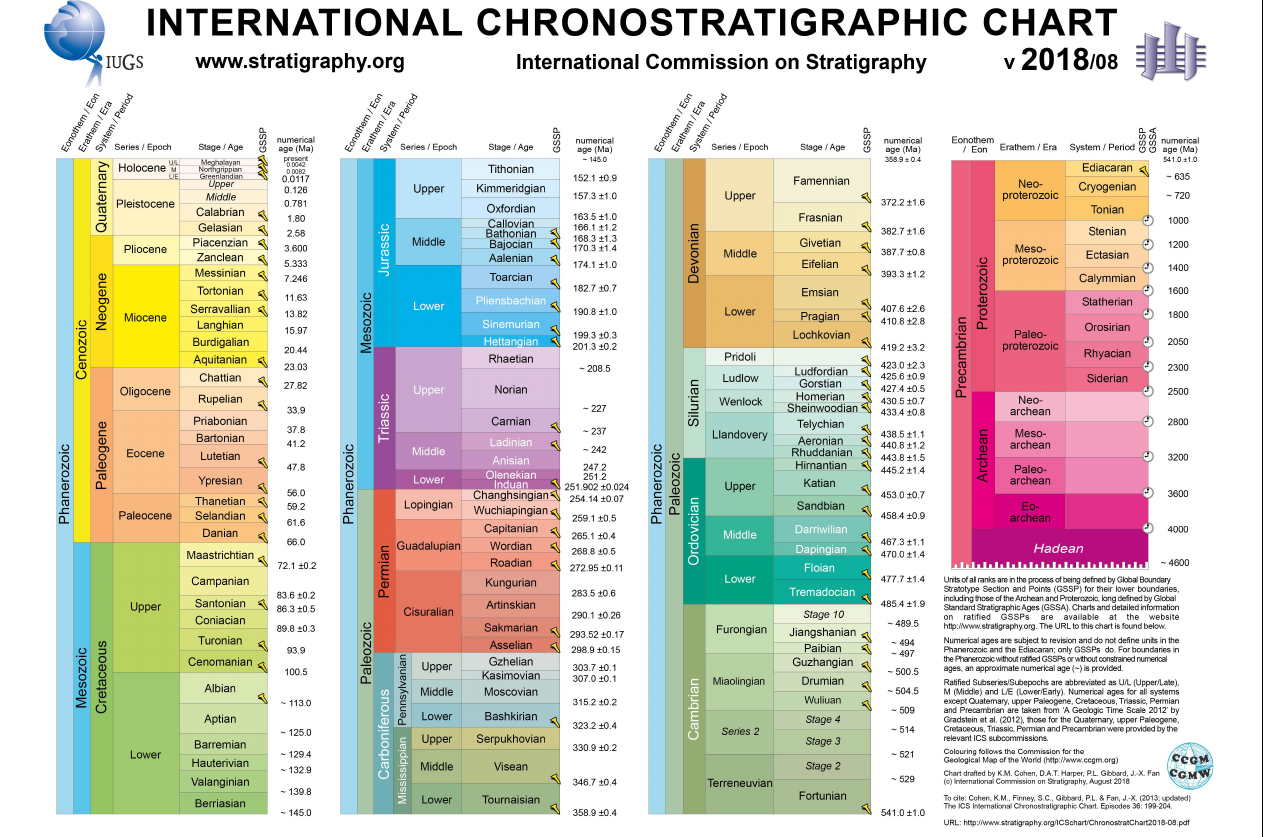
FIGURE 1 | The International Chronostratigraphic Chart of the ICS in its 2018 online version (Cohen et al., 2018,